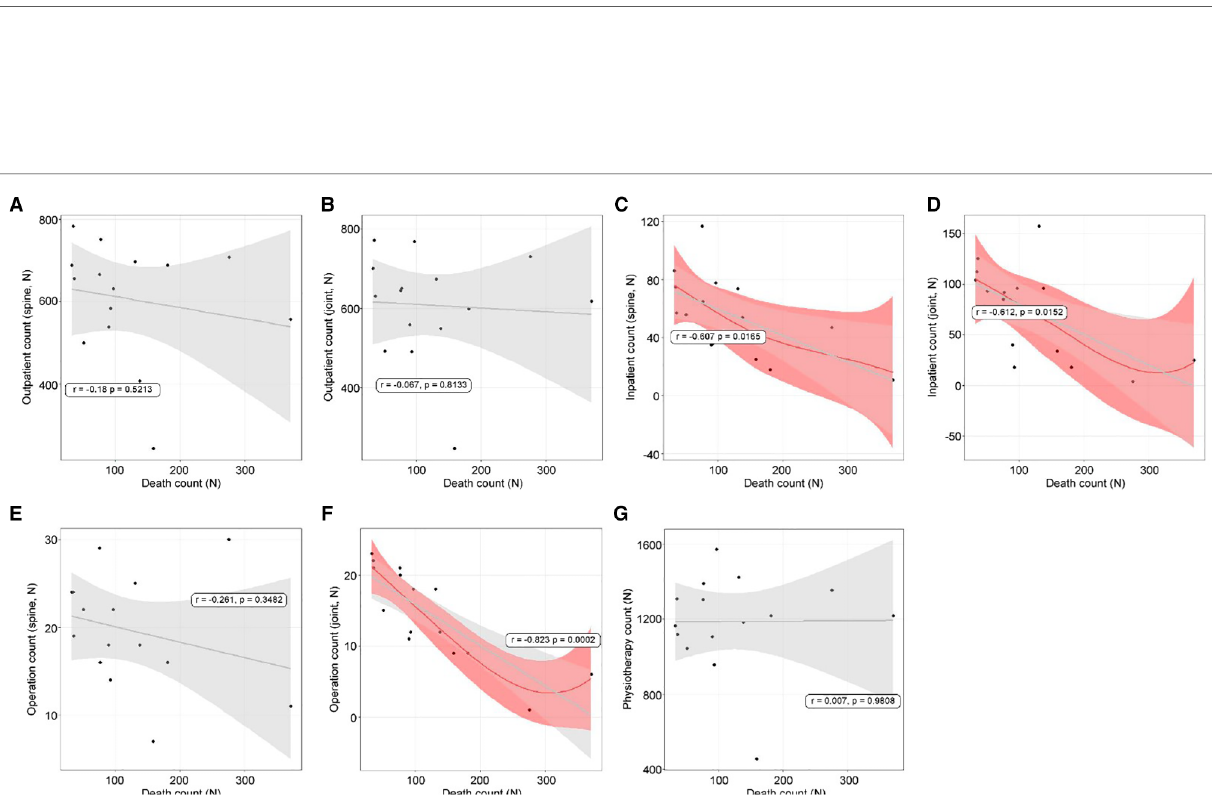
Frontiers in Surgery |